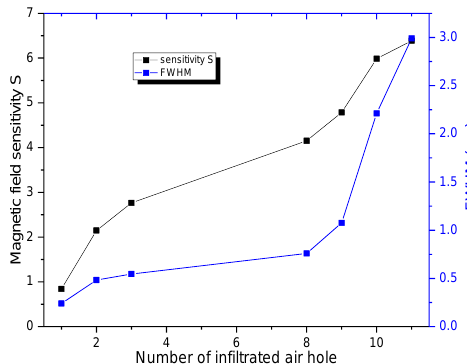
Figure 6. Magnetic field sensitiviy S and FWHM as functions of the number of infiltrated air holes.